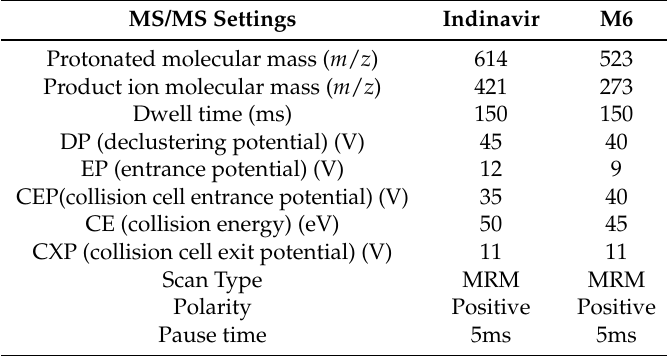
Table 6. MS/MS detector